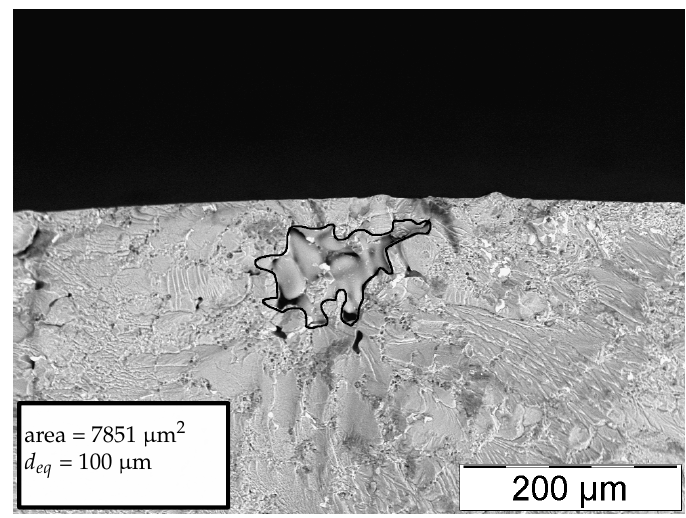
Figure 8. Representative fatigue fracture-initiating pore of position A.